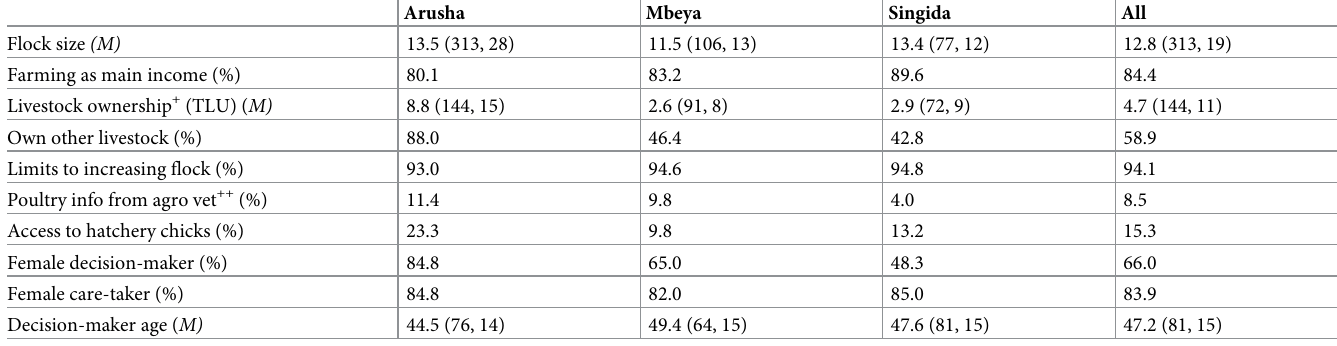
Table 1. Household and decision-maker characteristics by region, (range and standard deviation for continuous variables). Arusha Mbeya